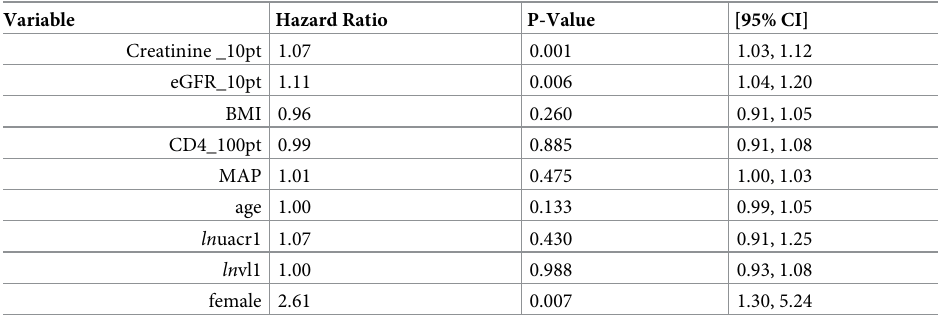
Table 3. Cox regression model for hazard ratio of TDF-associated nephrotoxicity.